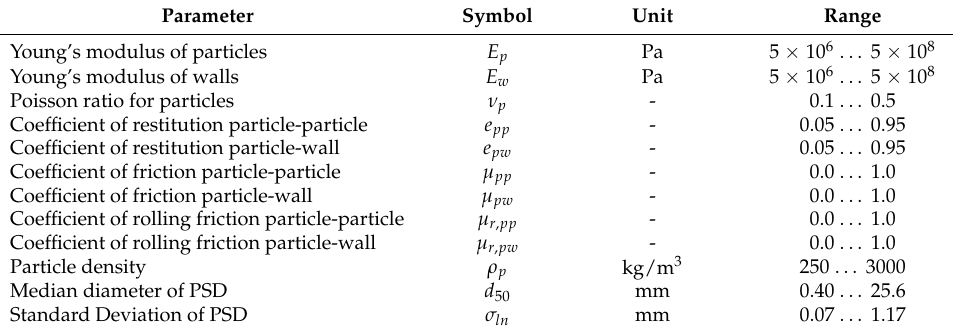
Table 2. Parameter ranges used for data generation. The ranges define the parameter space in which the metamodel is valid.